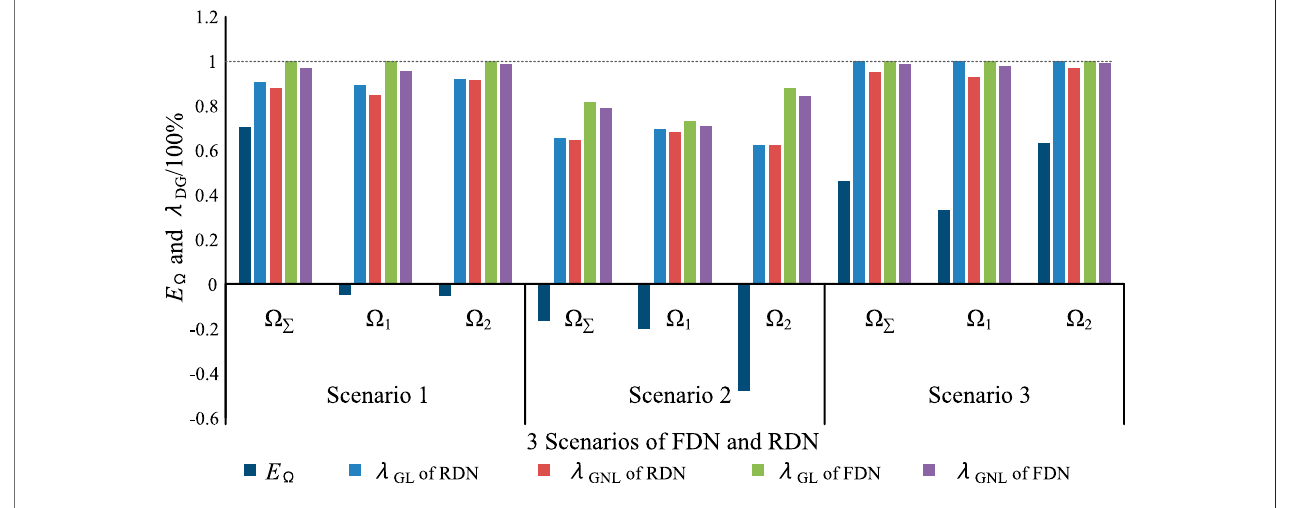
FIGURE 10 | MDs, GLARs, and GNLARs of all 3 scenarios for both the FDN and RDN.